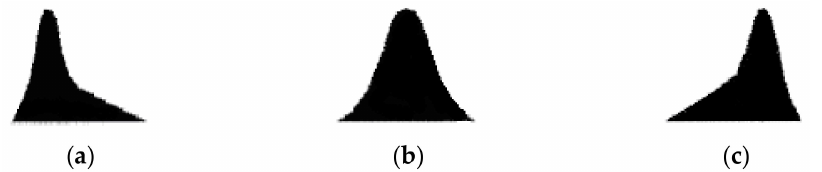
Figure 10. The shape of the skewed distribution: ( a ) negative value; ( b ) equal to zero; ( c ) positive value.